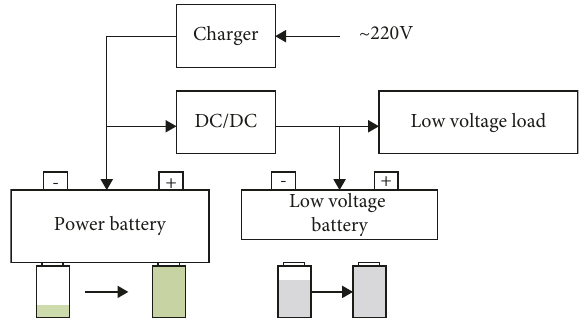
Figure 6: Energy management under charging